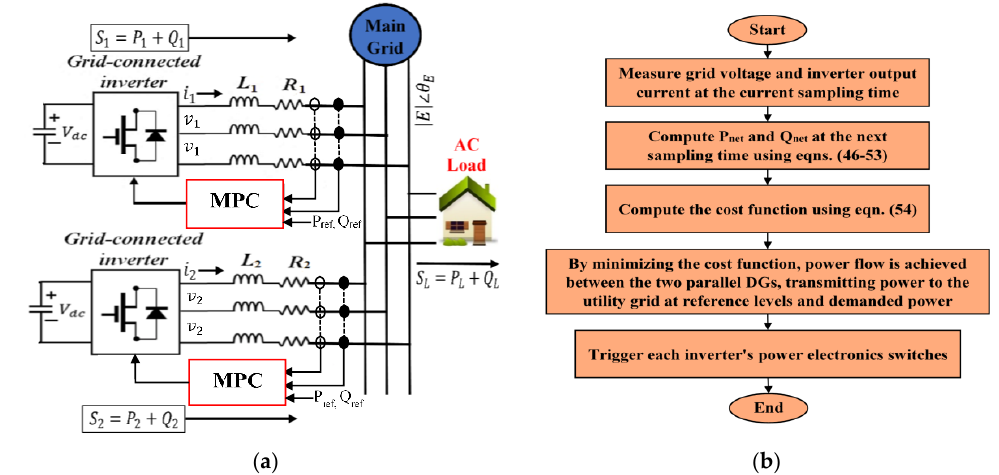
Figure 8. ( a ) The representation block diagram scheme of MPC and ( b ) the MPC flowchart.